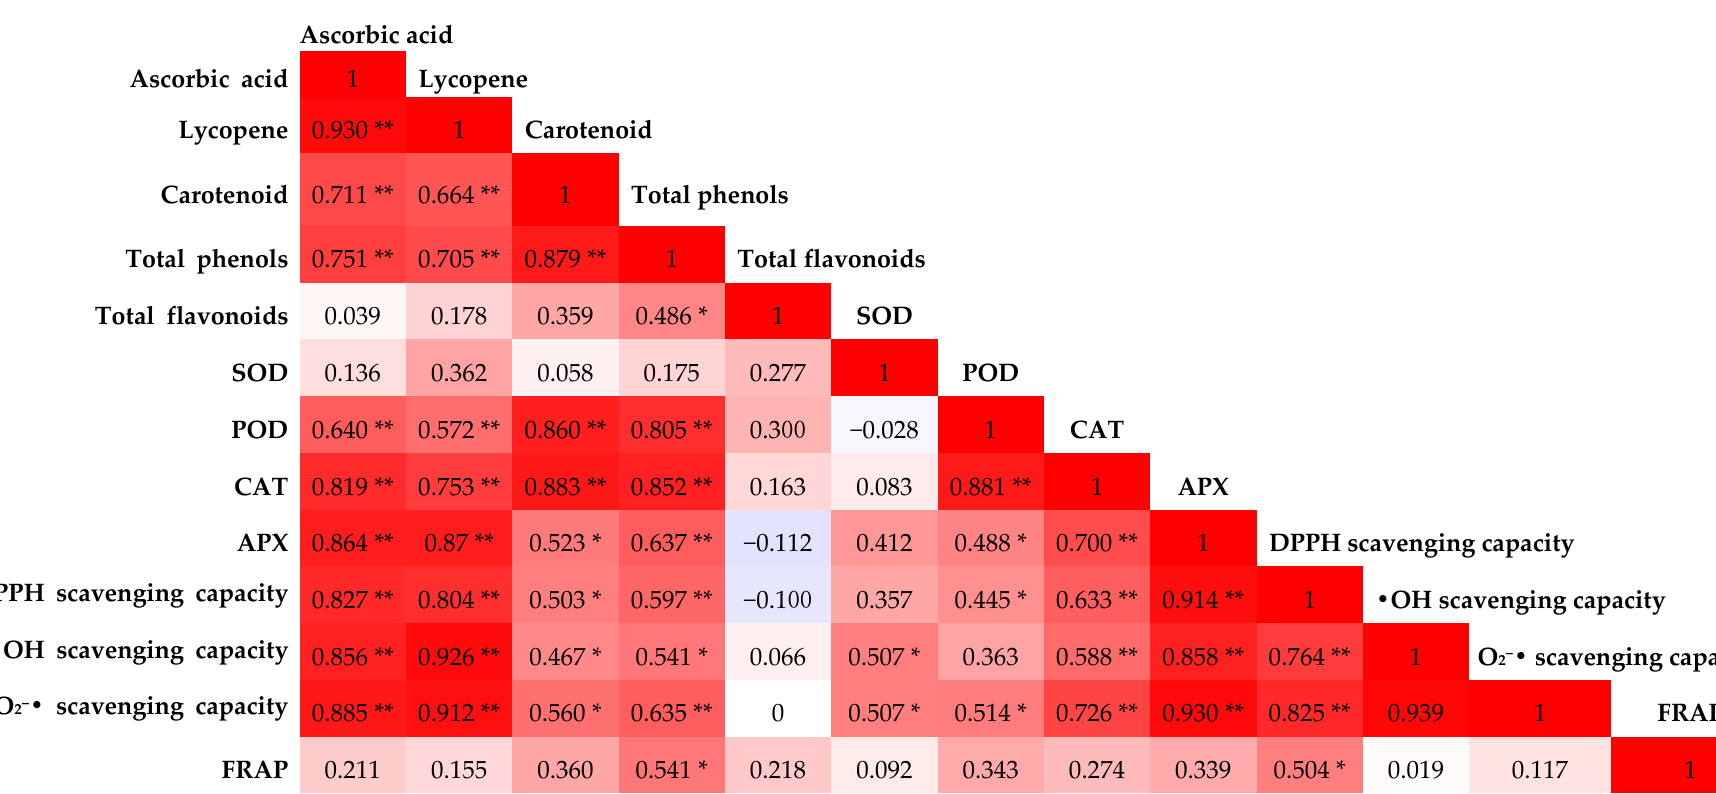
Figure 4. Correlation matrix based on Pearson’s correlation coefficient between the different antioxidant substances, antioxidant enzymes and antioxidant capacities. The color intensity and numbers are proportional to the correlation coefficients. Positive correlations are shown in red, and negative correlations, in blue. *,** means a significance of p = 0.05 and p = 0.01, respectively.